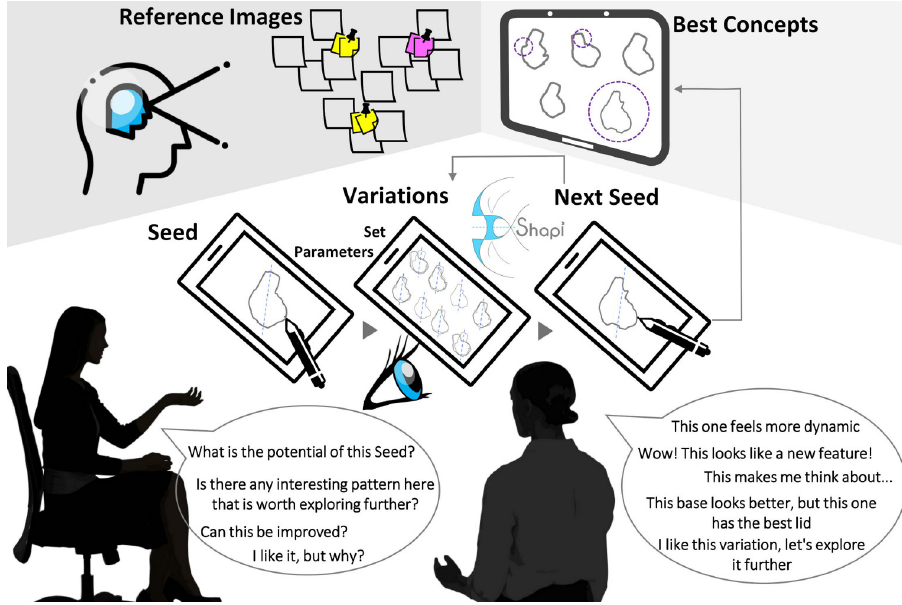
Fig 3. Suggested workflow: Using Shapi in a human-AI collaboration for early shape